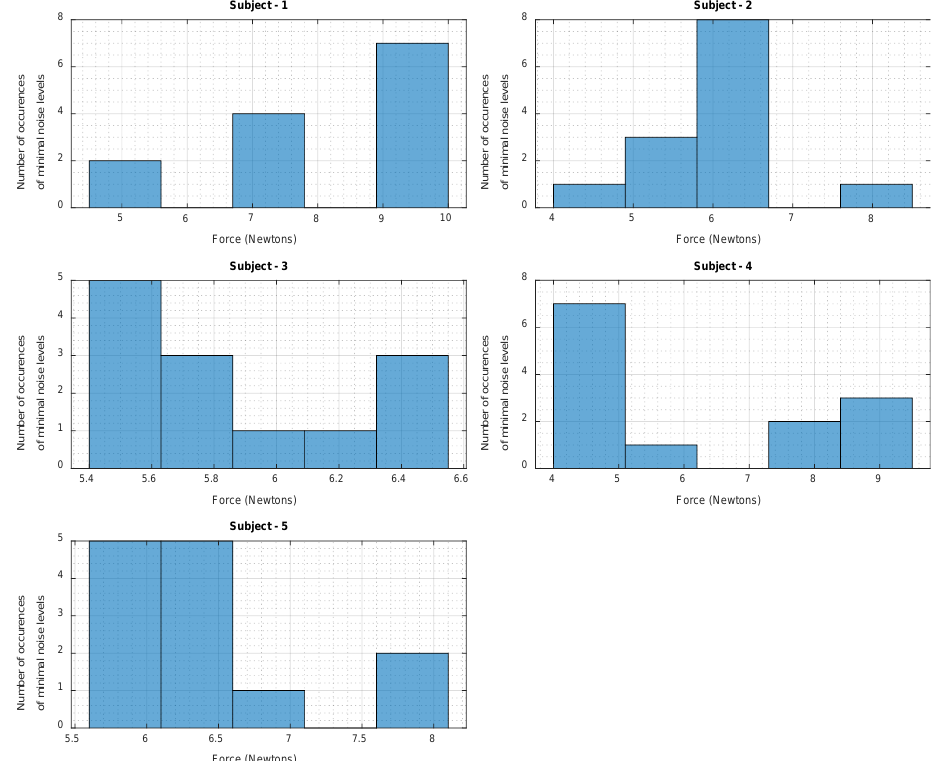
Figure 15. Histogram of WPAS force RMS values associated with low noise levels in heart sounds across activities for each subject.